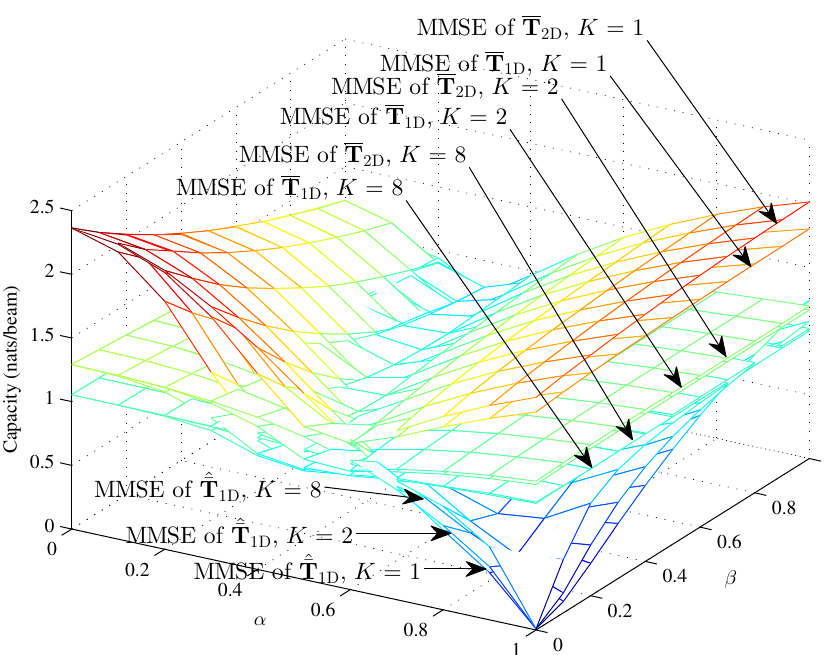
Figure 11. The MMSE capacity of the hybrid 1D model and modified hybrid 1D beams with γ = 10 and N = 100, hybrid 2D model with γ = 10, L = 50 and M = 50 ( K = 1, K = 2, K = 8 and κ = 50) versus α and β